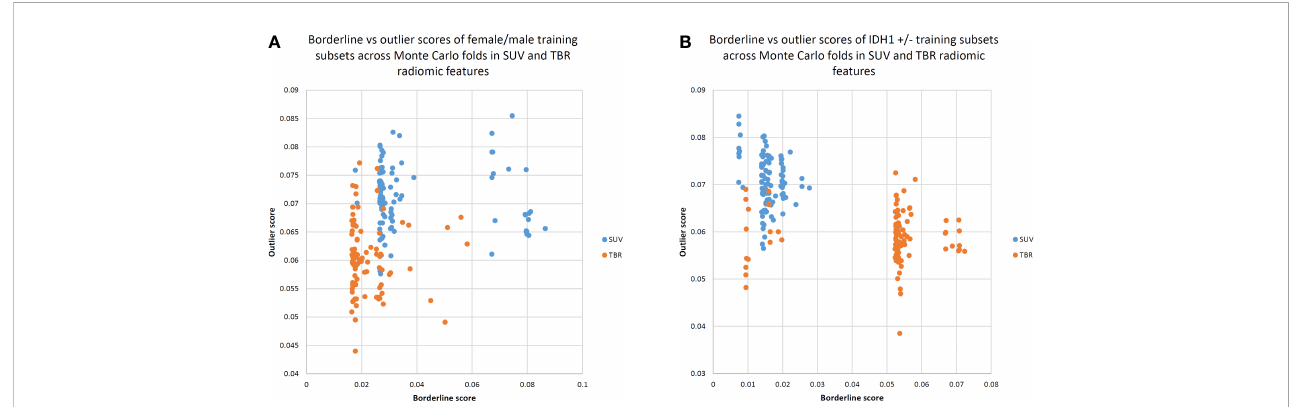
FIGURE 2 Borderline versus outlier scores of Monte Carlo training subsets for standardized uptake value (SUV) and tumor-to-background ratio (TBR) radiomic features to separate female/male (A) as well as IDH1 +/- (B) cases. Borderline scores were based on Tomek links (22), while outlier scores were calculated by the Isolation Forest approach (23). TBR features tend to demonstrate lower borderline scores, implying that male and female patients can be better separated in a TBR feature space. Low borderline and outlier scores indicate a better distinction between male and female patients in